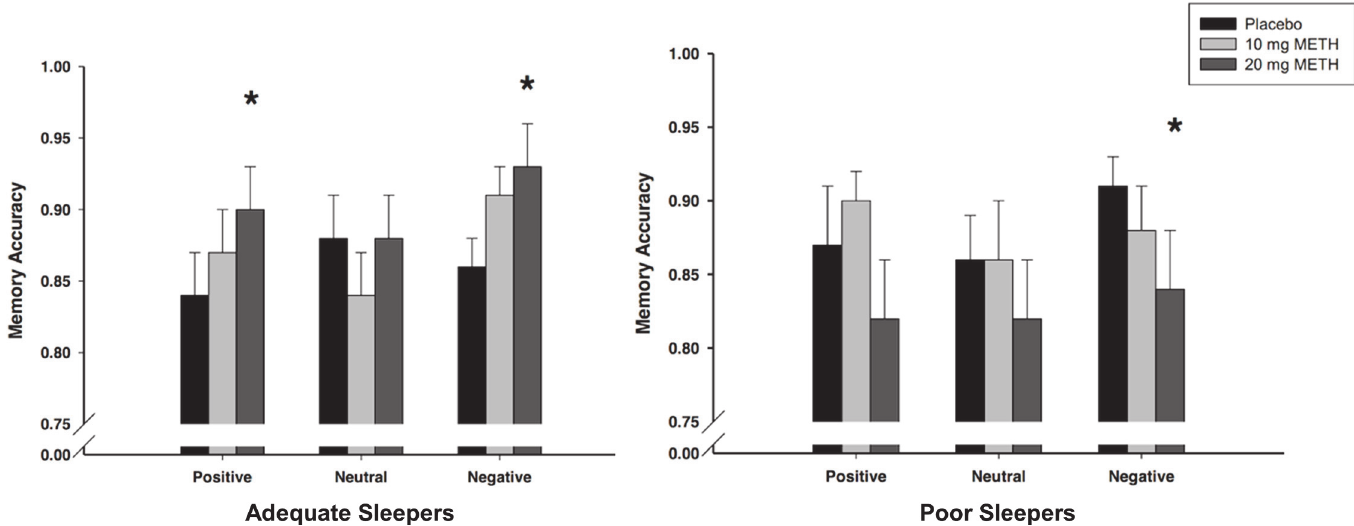
Fig 2. Meth effects on recognition by valence. Effects of METH on mean (+/- SEM) recognition accuracy for positive, neutral, and negative pictures among adequate sleepers ( n = 14; left panel) and poor sleepers ( n = 15; right panel) in the encoding group. 1 = perfect discrimination; 0 = no discrimination (chance responding). * p < .05 compared to placebo